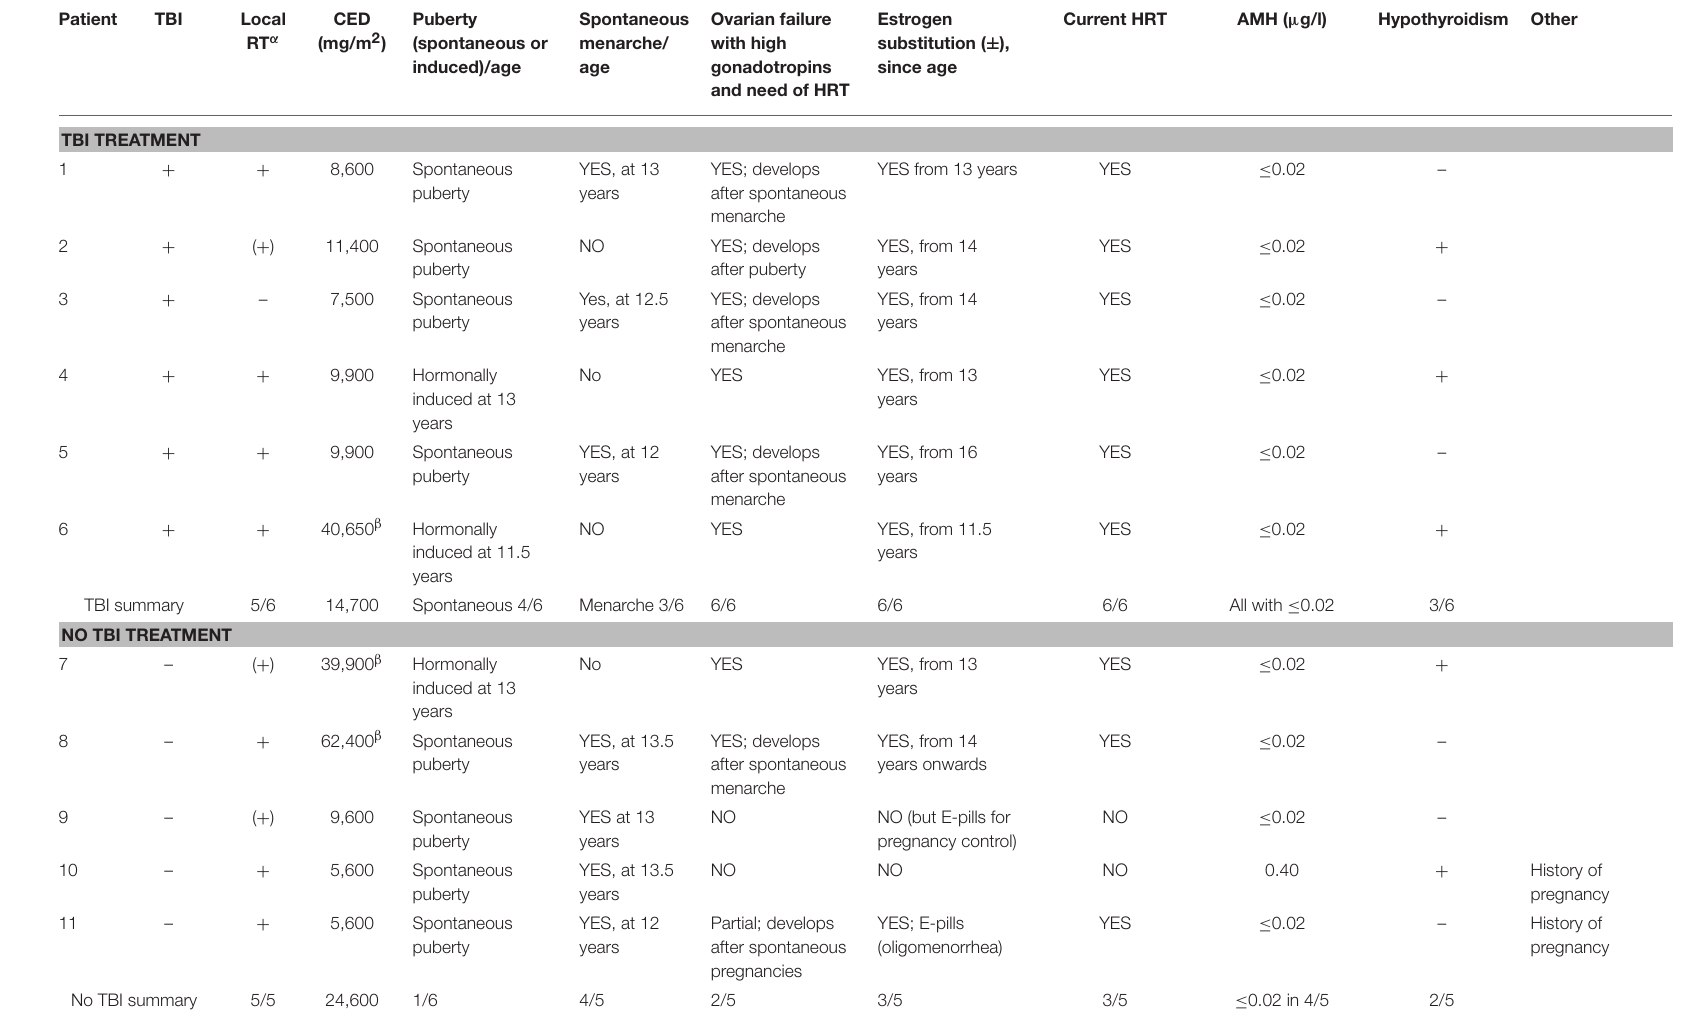
TABLE 3 | Pubertal development, need of hormone substitution and cumulative alkylating chemotherapy in female survivors ( n = 11) of childhood high-risk neuroblastoma.